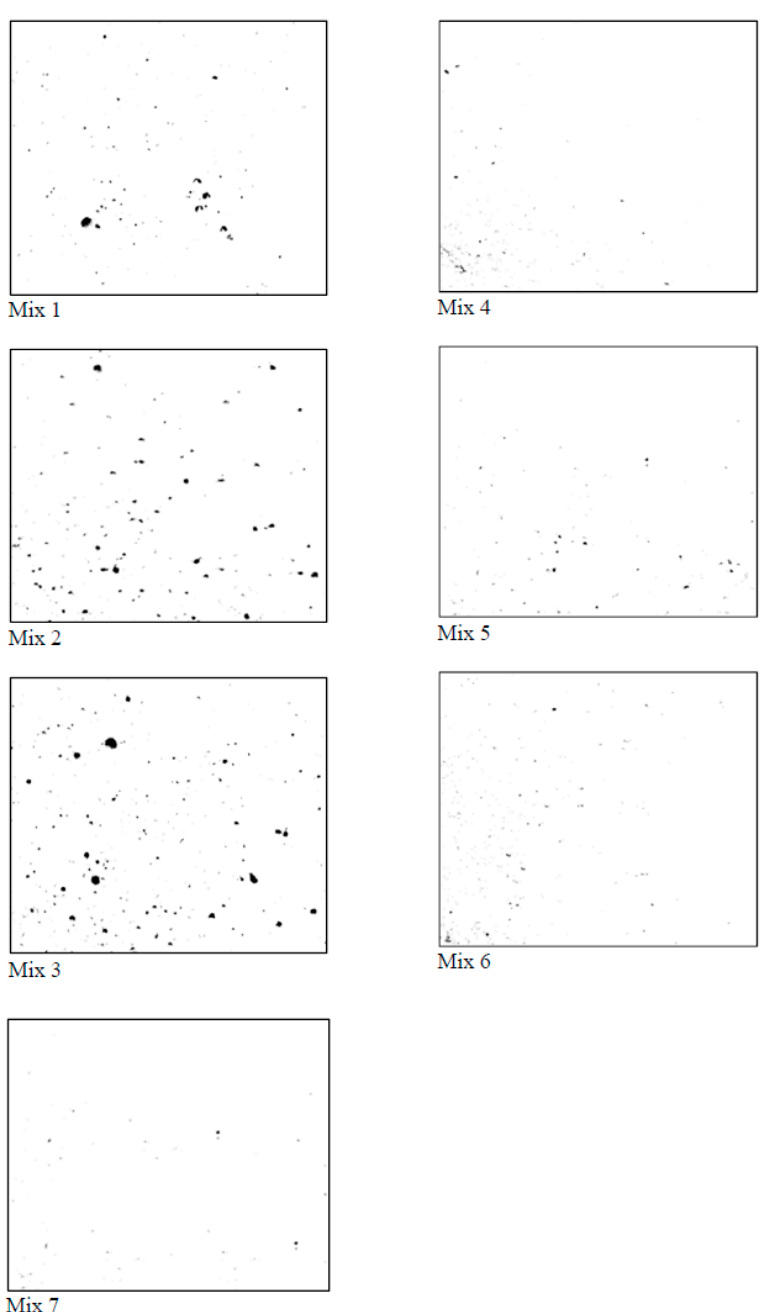
Figure 6. Binary analysis of the cross-section of different concrete mixes.